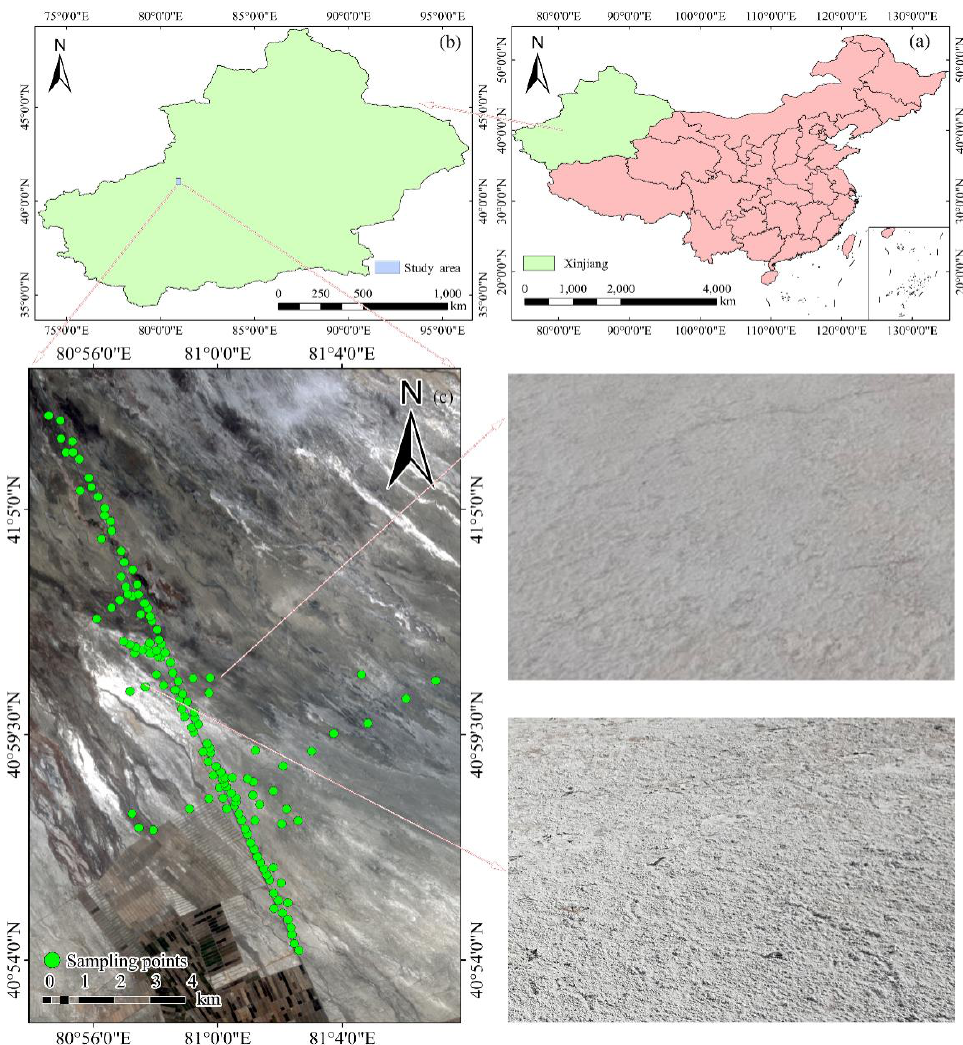
Figure 1. Study area and sampling points within Xinjiang Province. The location of Xinjiang, China ( a ), the location of the study area ( b ), and the distribution of sampling points ( c ).